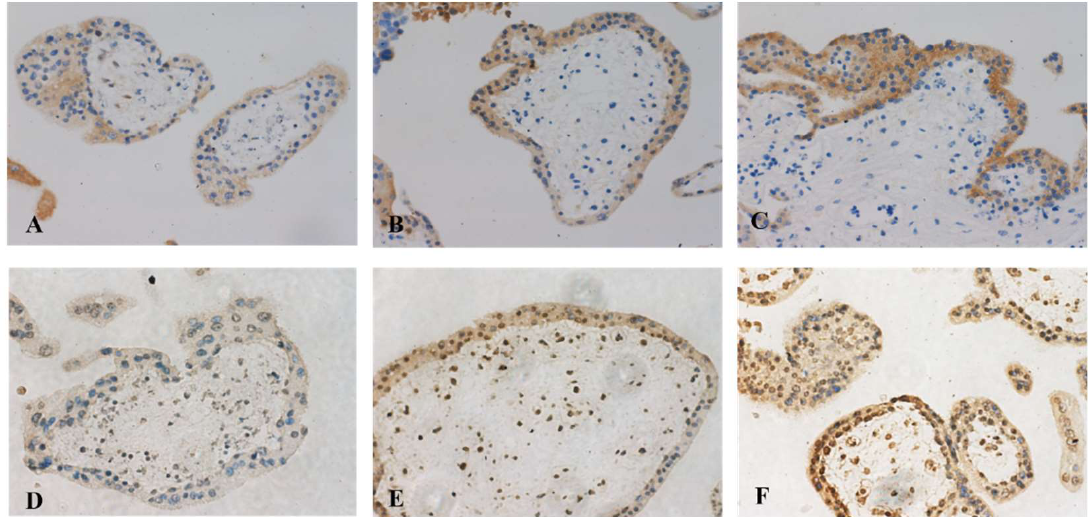
Figure 6. Representative images of immunohistochemistry showing increased levels of γ H2AX ( A – C ) and p21 ( D – F ) in healthy placental explants that had been treated with large EVs ( B , E ) and small EVs ( C , F ) derived from missed miscarriage placentae, compared to untreated cells ( A , D ). (magnification: 400×).